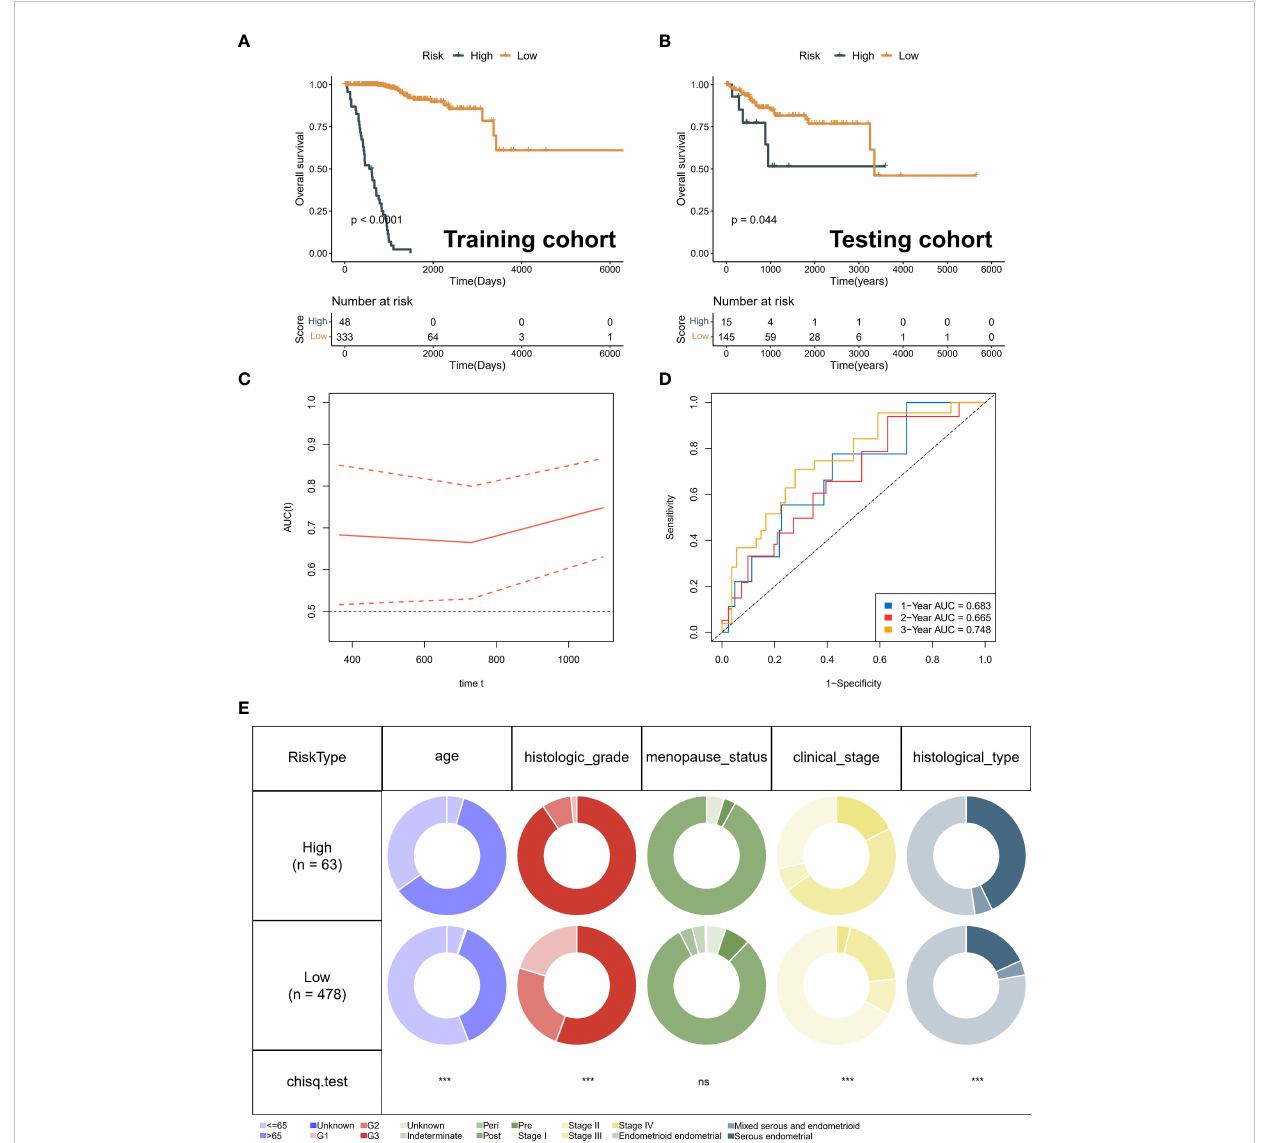
FIGURE 6 Validation of prognostic signature. (A) Kaplan-Meier analysis of different risk group in training cohort. (B) Kaplan-Meier analysis of different risk group in testing cohort. (C) Risk score distribution map and optimal cut-off value selection. (D) The area under the ROC curve (AUC) for the 1-year, 2-year, and 3-year OS in the testing cohort. (E) The distribution between risk groups and clinical features. ns, no statistical signi fi